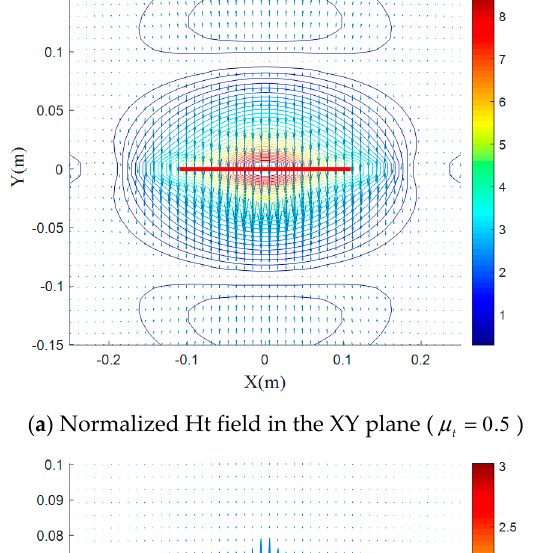
μ with 253 . == εε and 1 = μ , in the z tz t